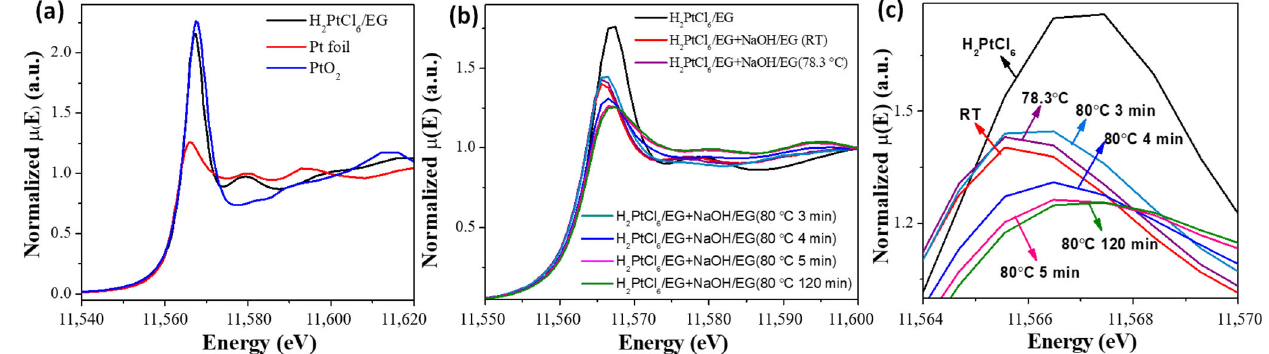
Figure 4. Pt L 3 ‐ edge XANES spectra. ( a ) The reference of Pt foil, H 2 PtCl 6 glycol solution and PtO 2 powder; ( b ) time evolution of reaction mixture for preparing Pt nanoclusters; ( c ) the enlarged image of the absorption peak at ca. 11565 eV. Reproduced with permission, Copyright 2020 Editorial Office of Acta Physico ‐ Chimica Sinica [102] . Table 2. Fitting parameters of the Pt–Cl, Pt–O, and Pt–Pt bonds obtained from the Pt L 3 -edge EXAFS spectra of reaction mixture for preparing unprotected Pt nanoclusters. Reproduced with permission,